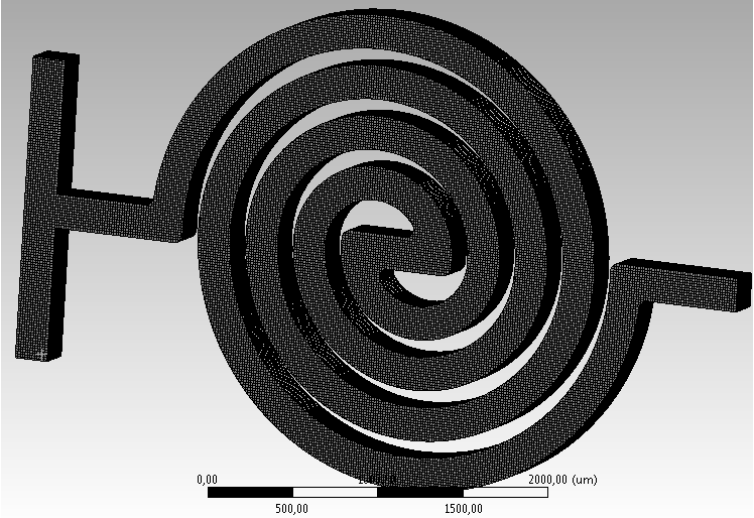
Figure 1. Presentation of the 3D spiral mixer numerical model. Channel depth of 230 µm and width of 200